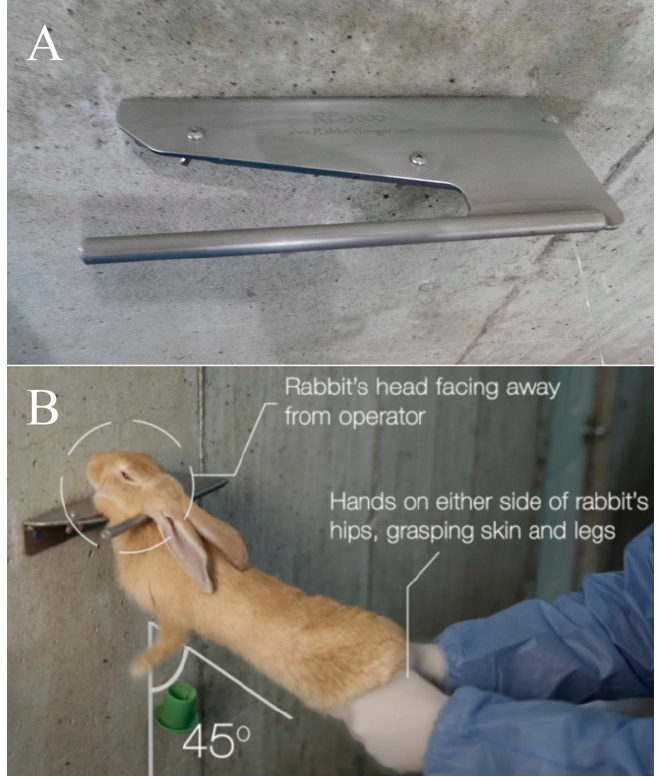
Figure 1. ( A ) Device employed for mechanical cervical dislocation, and ( B ) positioning of animal for correct application.